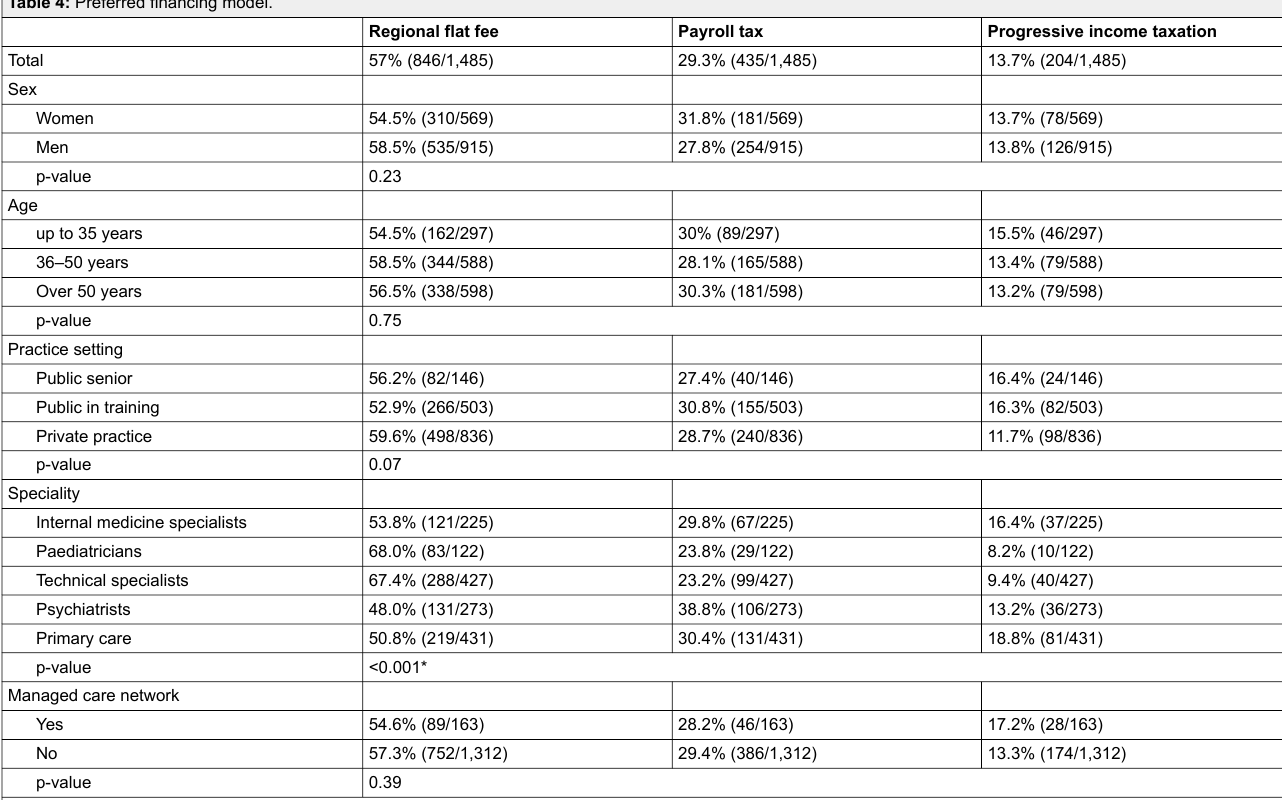
Table 4: Preferred financing